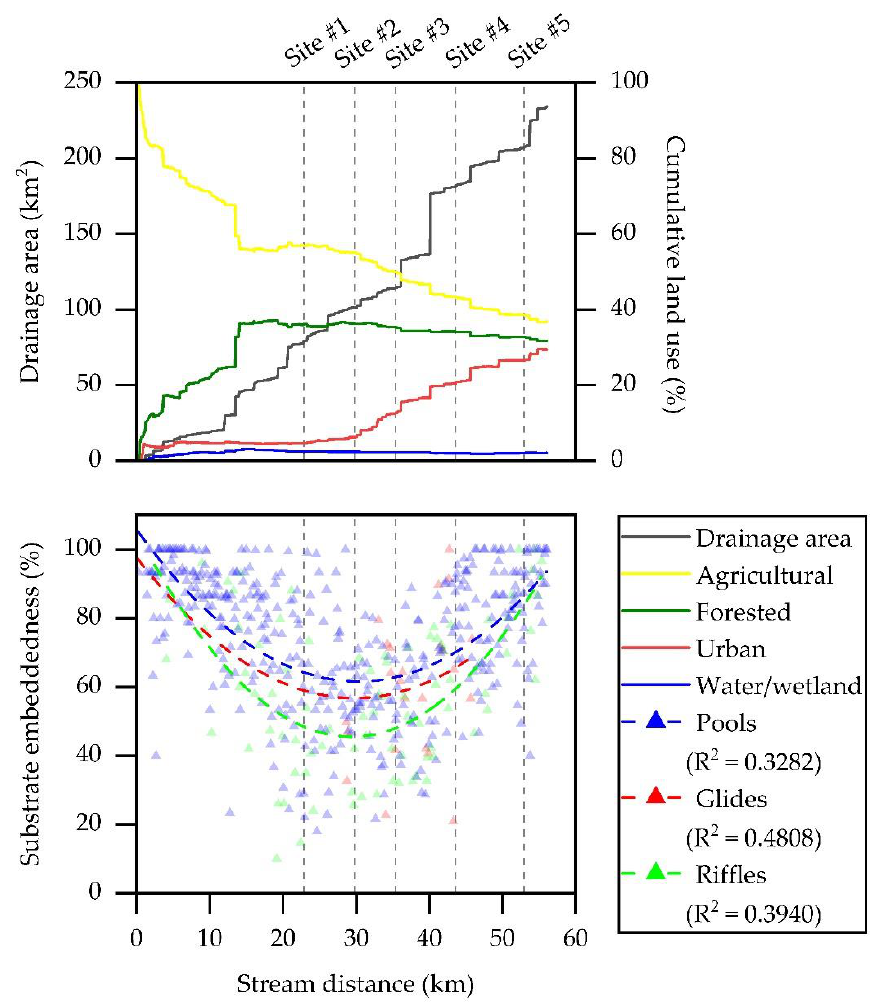
Figure 7. Watershed characteristics and trend lines associated with substrate embeddedness in pools, ri ffl es, and glides with downstream distance (km) in Hinkson Creek Watershed, Missouri, USA. Vertical lines show location of five nested gauging